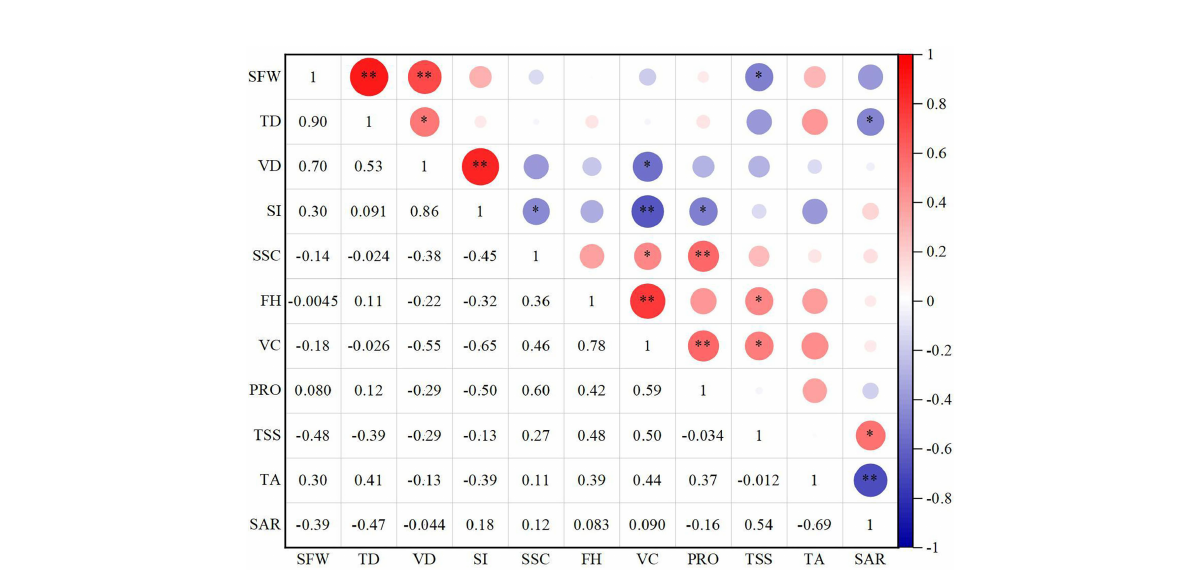
FIGURE 1 Spearman correlation analysis of fruit quality indicators of fragrant pear. Red and blue represent the positive and negative correlations among the quality indicators. The darker colour represents the stronger signi fi cance. ** refers to the 0.01 level, which indicates a signi fi cant correlation. * refers to the 0.05 level, which indicates a signi fi cant correlation. SFW, TD, VD, SI, SSC, FH, VC, PRO, TSS, TA, and SAR represent abbreviations of single-fruit weight, transverse diameter, vertical diameter, shape index, soluble solid content, fruit hardness, vitamin C, protein, total soluble sugar, titratable acid, and sugar-acid ratio respectively. The numbers in the left half of the fi gure represent the correlation coef fi cients between indicators (r).